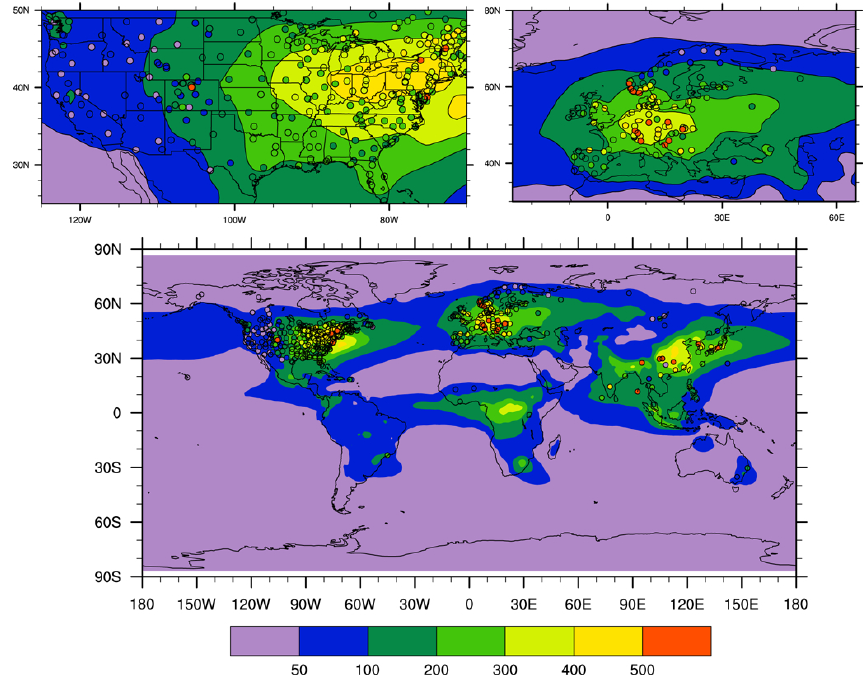
Fig. 1a. Nitrate wet deposition (mg(N)m − 2 yr − 1 ) for 2000. Contours are for the multi-model mean; filled circles are for the wet deposition network observations.